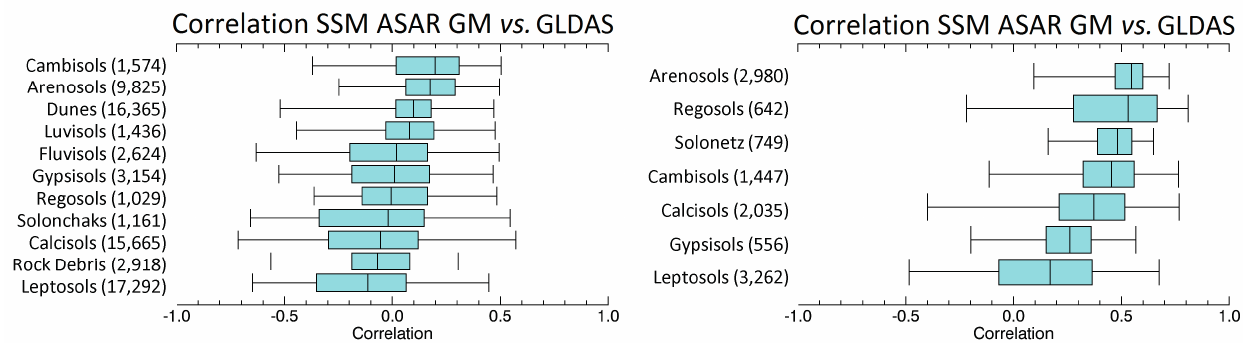
Figure 7. The box-plot representation of the correlation results for 5-km Advanced Synthetic Aperture Radar (ASAR) Global Monitoring (GM) and the Noah model from the Global Land Data Assimilation System (GLDAS-NOAH) Surface Soil Moisture (SSM) stratified by the Harmonized World Soil Database soil types for specific land cover class and precipitation categories. The boxes show the median, 25th and 75th percentiles; the lines represent minimum and maximum values after outlier removal (first and 99th percentile). The amount of 5-km ASAR pixels used for the evaluation for each class is shown in brackets behind the class name. ( Left ) barren or sparsely vegetated land cover classes with annual rainfall of 100 to 250 mm; ( Right ) scrubland land cover class with annual rainfall of 400 to 500